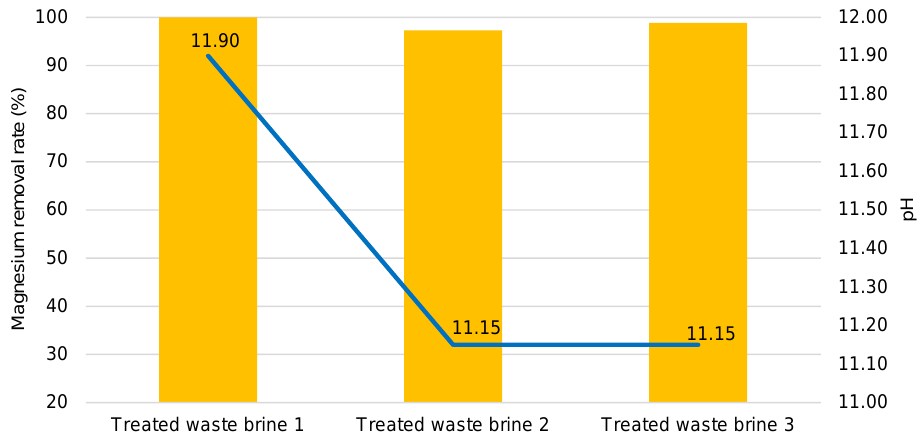
Figure 3. Removal rate of magnesium ions from waste brine at a pH above 11.